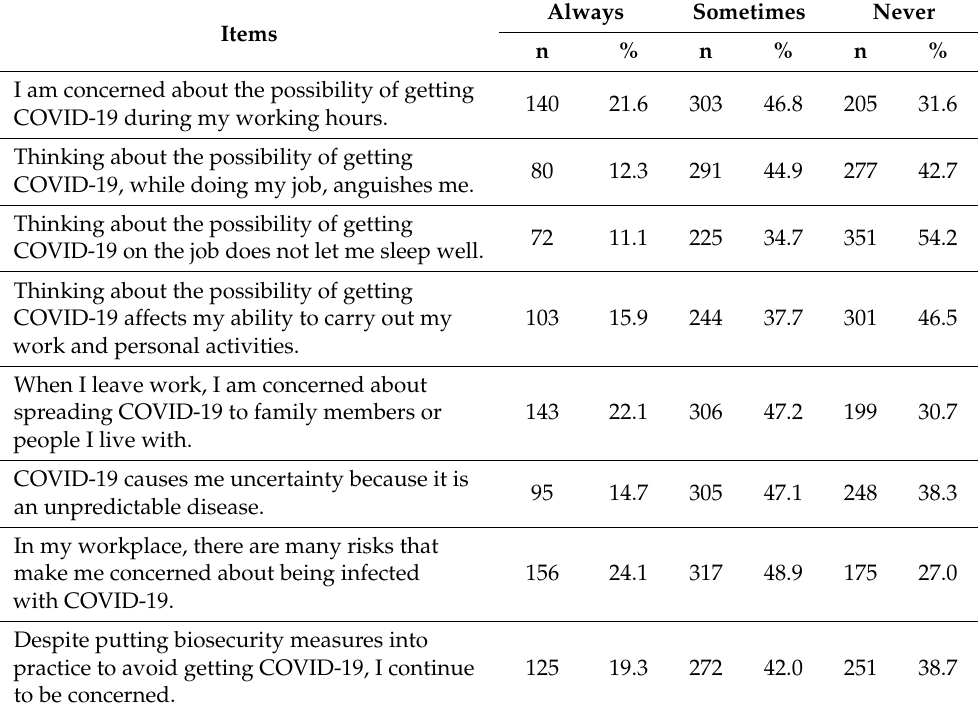
Table 2. Answers to the questions related to the Scale of Concern of Contagion of COVID-19.